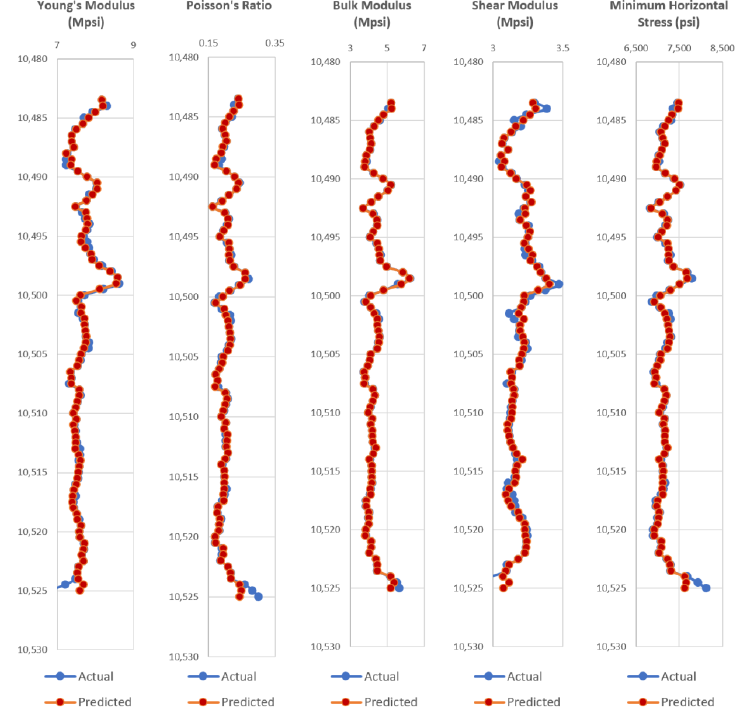
Figure A10. Actual and predicted geomechanical properties along with depth (feet) for test well 5 in McKenzie County for the Middle Bakken Formation.